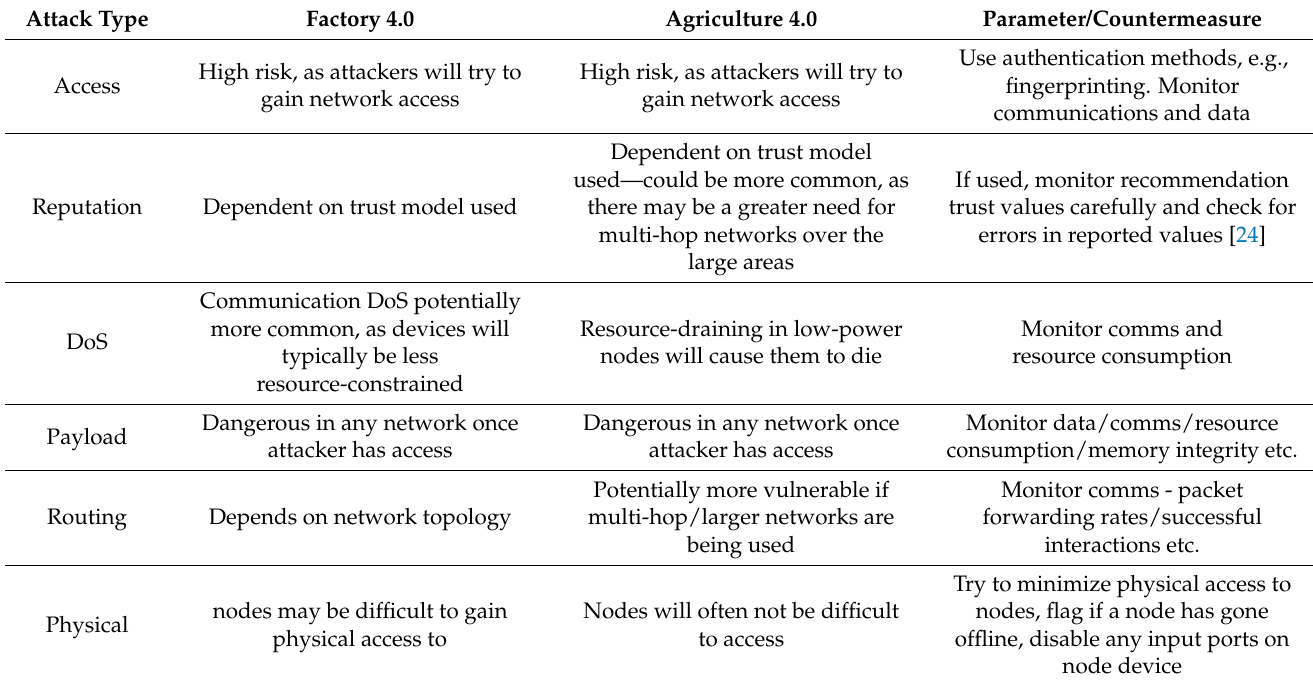
Table 3. Comparison of attack types on Factory and Agriculture